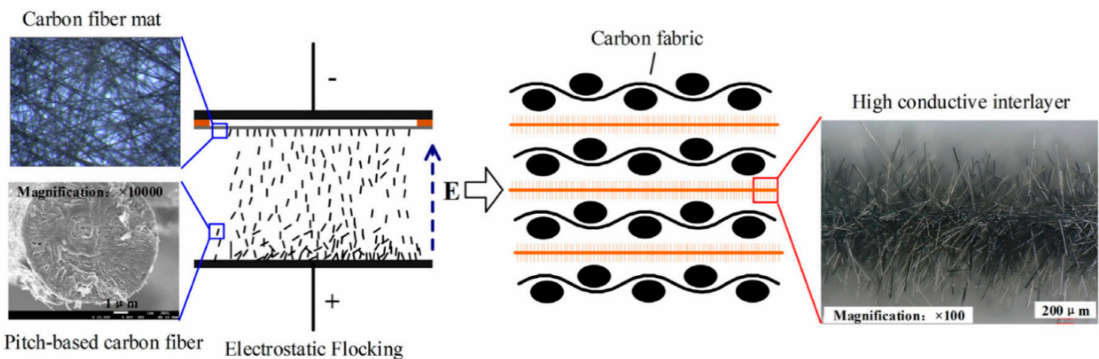
Figure 5. Schematic process of the electrostatic flocking method for CF mat preparation. Reprinted with permission from [57]. Copyright 2018 Elsevier Ltd.